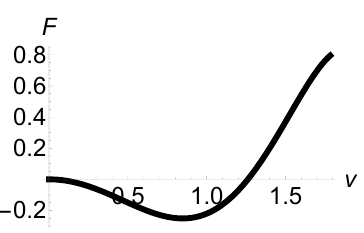
Figure 1 . The e(cid:11)ective potential (free energy density) as a function of the VEV v for (cid:22) B = 1, m = 0 : 5 and g 4 =